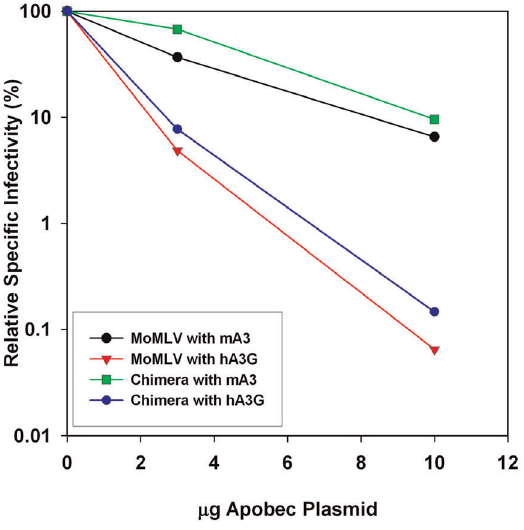
Figure 2. Effects of the different APOBEC3s on the infectivity of MoMLV and chimera viruses. Virus particles were produced by transient transfection of viral clones together with pBABE-Luc and 0, 3, or 10 m g of either mA3 or hA3G expression plasmids. Specific infectivities were calculated as described in Materials and Methods, dividing the luciferase activity values by the RT activity values; specific infectivity of samples produced without APOBEC3 is set to 100%. Black line, MoMLV with mA3; green, chimera with mA3; red, MoMLV with hA3G; blue, chimera with hA3G. Results are plotted vs. the quantity of APOBEC3 plasmid used in the transfections to generate the viruses.